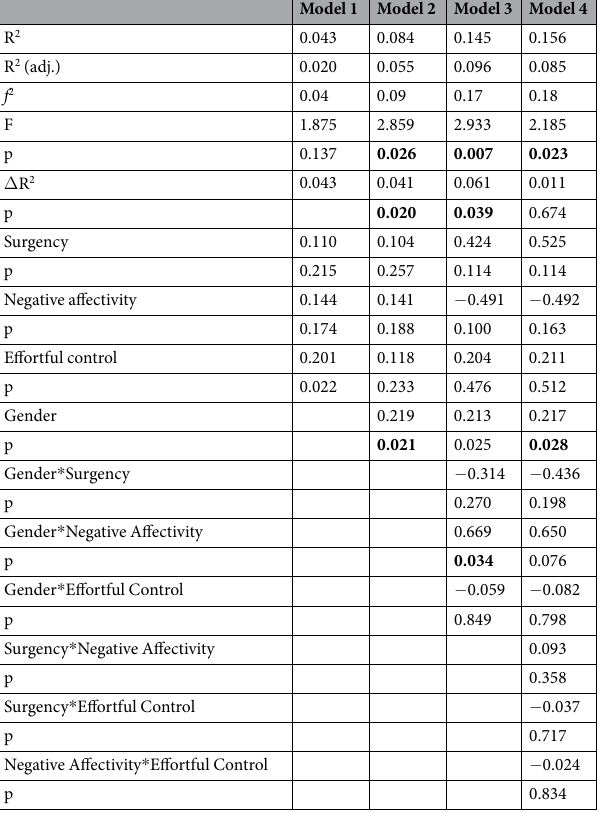
Table 2. Categorical regression (CATREG) models in the total sample regressing the total COBEL scores on the three temperamental factors (Model 1), gender (Model 2), interaction of temperament and gender (Model 3), and interactions among the temperamental factors (Model 4). Gender is coded as 0 = boy and 1 = girl. The predictor-related values represent β s . Significant effects to be interpreted are highlighted in bold. The model that seems to provide the best explanation is Model